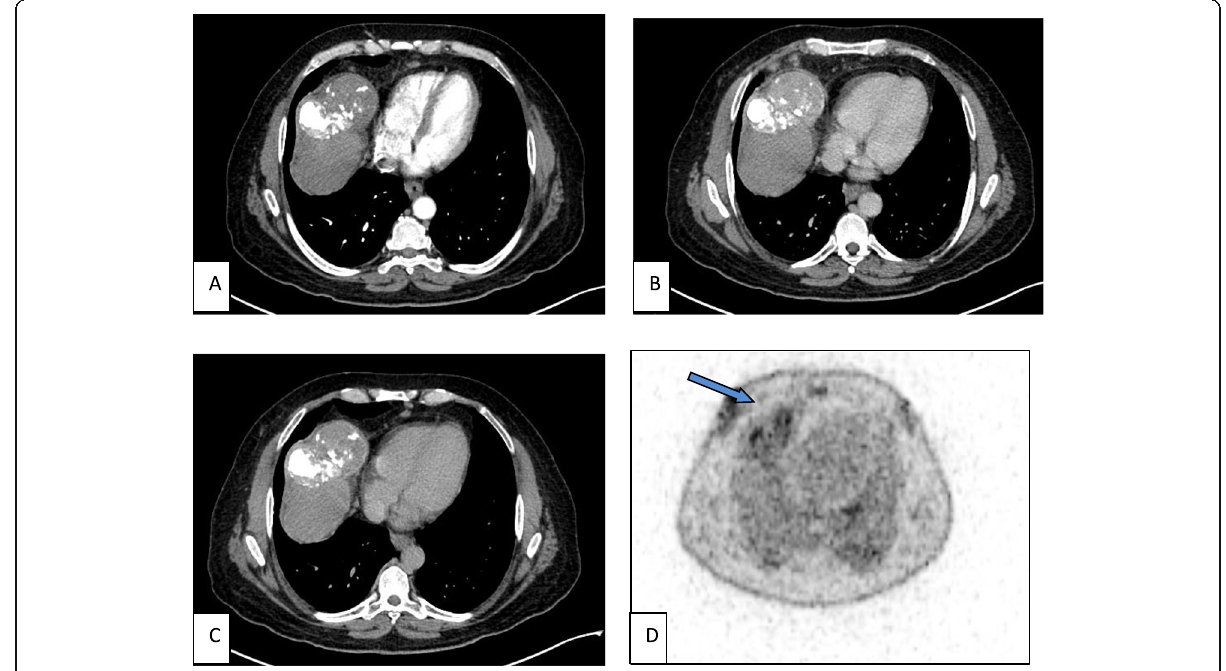
(cid:1) Table 2 shows the association between the true local residue/recurrence (which is detected in follow-up) and detection of local residue/recurrence by CECT and PET